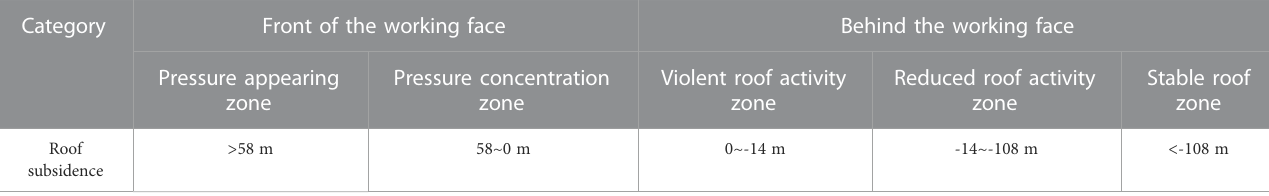
TABLE 5 Roof subsidence